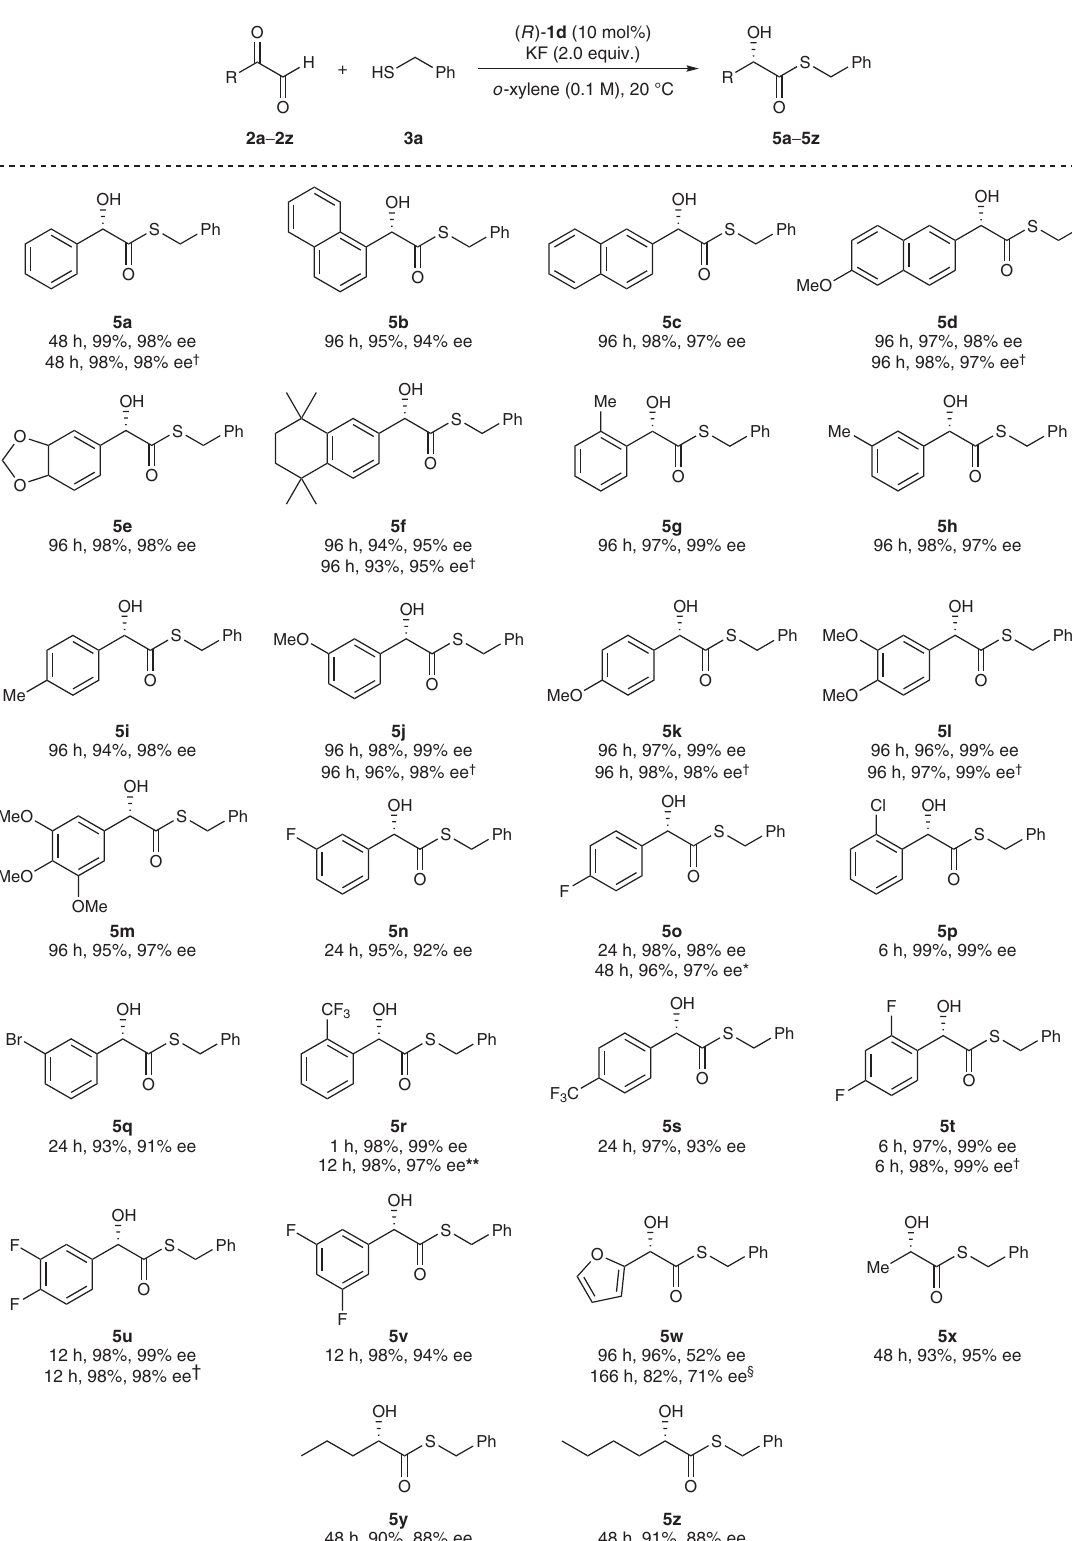
Figure 3 | Substrate scope of the reaction. The reactions were carried out with 2 (0.1mmol, hydrate form), 3a (1.0 equiv.), ( R )- 1d (10mol%) and KF (2.0 equiv.) at 20 (cid:2) C. Isolated yield. w Using ( S )- 1d (10mol%). *Using ( R )- 1d (5mol%). **Using ( R )- 1d (1mol%). y Using ( R )- 1d (30mol%) at 0 (cid:2)